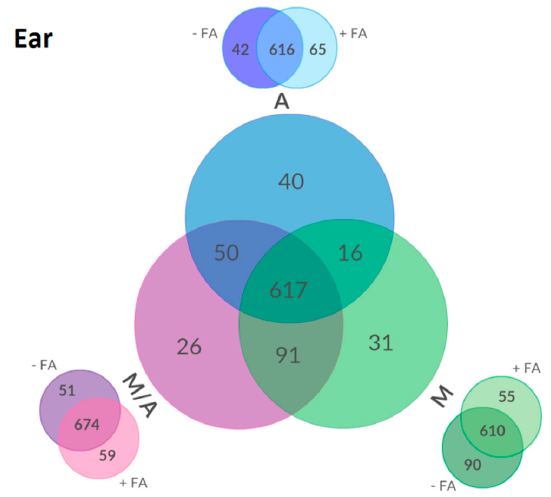
Figure 3. Venn diagram of metabolites detected in ear samples. Metabolite numbers in the large circles refer to the consistent findings (three of three replicates) in at least one type of the respective extraction mixture (non-acidified or acidified form). Small Venn diagrams on the outer side represent the distribution of all metabolites between non-acidified and acidified extraction variants. FA: formic acid.